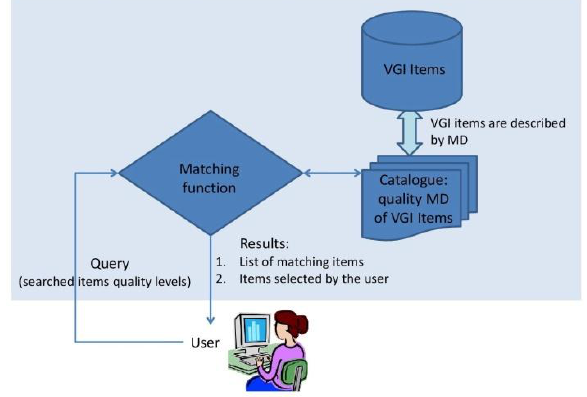
Figure 2: high level sketch of the user driven VGI items selection based on querying quality